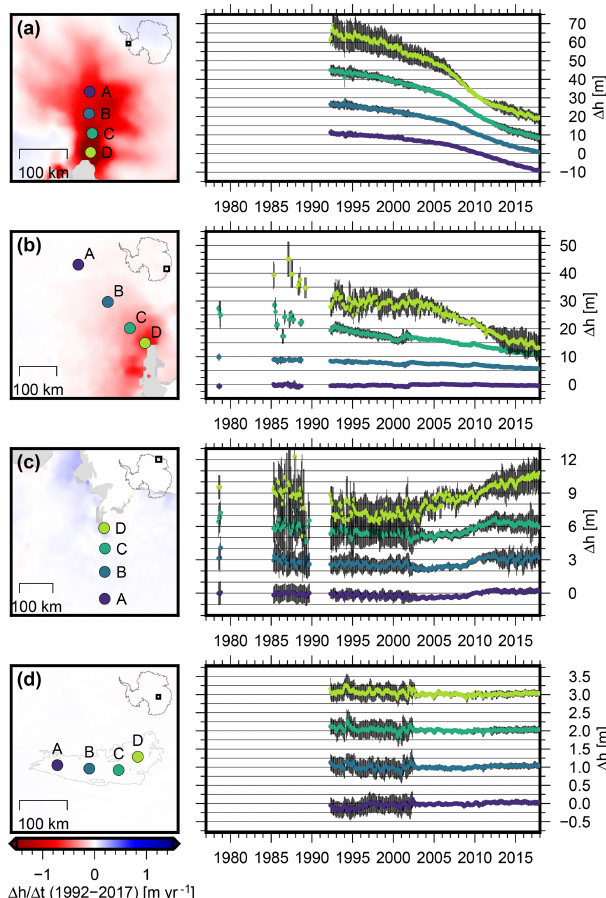
Figure 10. Multi-mission SEC time series in four selected regions (a) Pine Island Glacier, (b) Totten Glacier, (c) Shirase Glacier in Dronning Maud Land and (d) Lake Vostok (marked by P, T, S and V in Fig. 9b). The time series of points B, C and D are shifted along (cid:49)h for better visibility and the one σ uncertainty range is displayed in black. The maps on the left show the elevation change rate be- tween 1992 and 2017 as in Fig. 9b (but in a different color